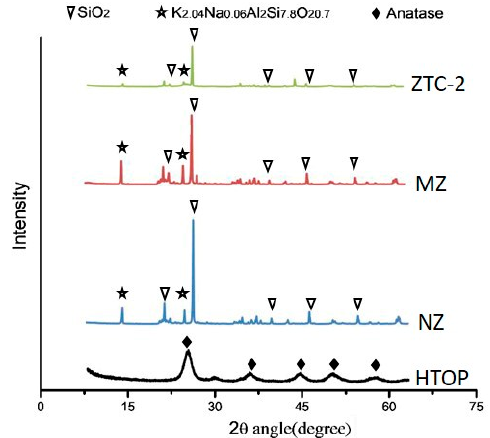
Figure 2. X-ray diffraction patterns of HTOP, NZ, MZ, and ZTC-2.